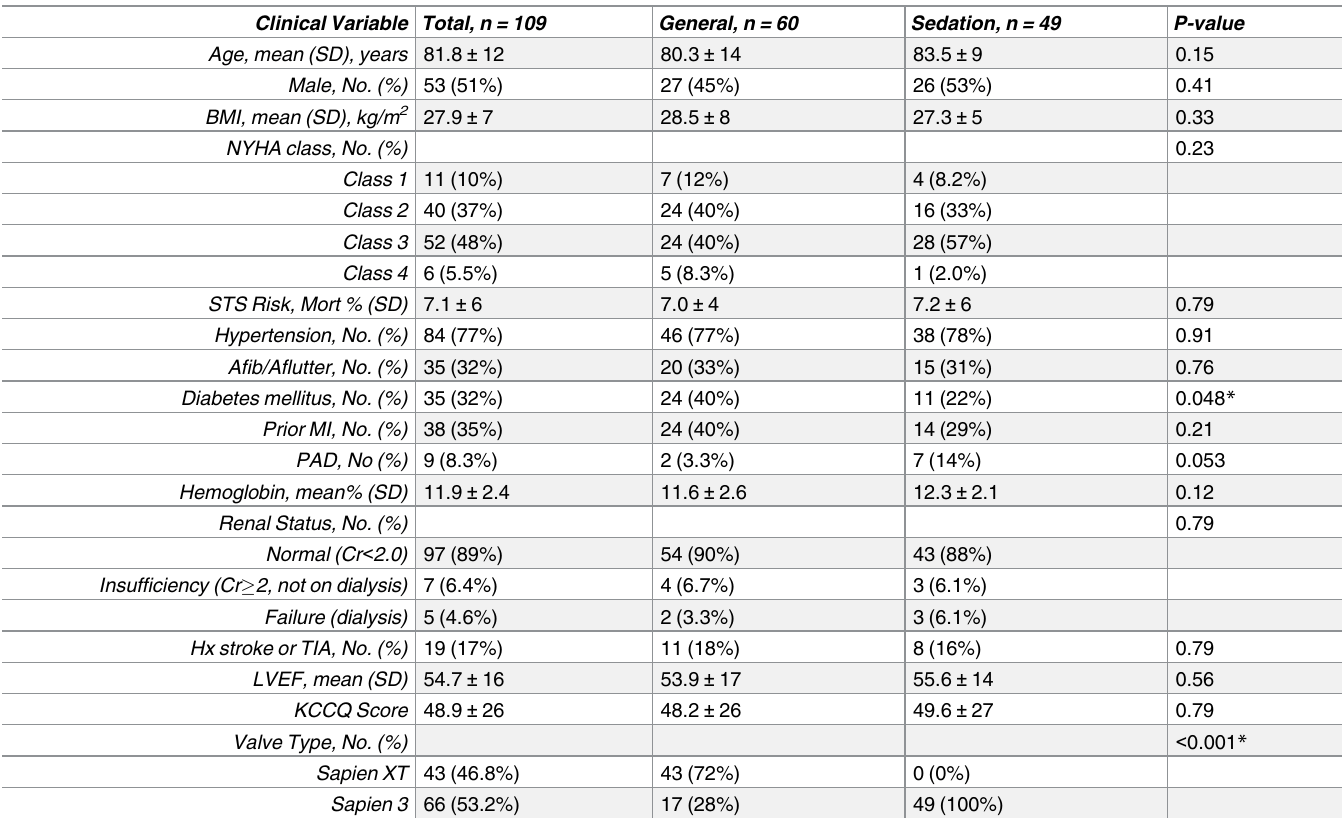
Table 5. Patient characteristics; excluding Sapien 1 valves and transapical